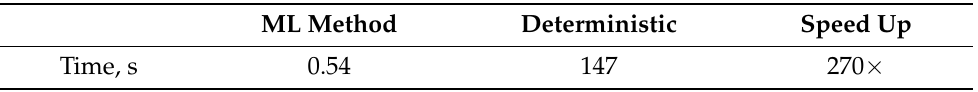
Table 1. Time to perform one evaluation of the collision operator using machine-learned collision operator and the O ( n 6 ) deterministic method of